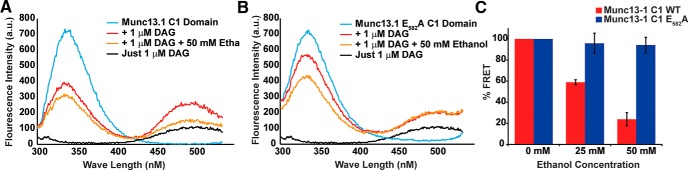
Ethanol binding to the C1 domain inhibits DAG binding. A, Spectral emission after excitation at 290 nm reveals FRET between the Munc13-1 C1 domain and dansyl-DAG (red trace). The C1 domain emission peaks at ∼335 nm (cyan trace), while the dansyl-DAG emission peak is found at 500 nm (black trace). This FRET is disrupted by 50 mM ethanol (green trace). B, Spectral emission of the Munc13-1 E582A mutation after excitation by 290-nm light is shown. C, The binding of dansyl-DAG as revealed by FRET emission at 500 nm is reduced at both 25 and 50 mM ethanol concentrations. The E582A C1 domain mutation fails to bind ethanol (Das et al., 2013). Ethanol does not inhibit dansyl-DAG binding to the E582A Munc13-1 C1 domain (n = 3 each; *p < 0.05, ***p < 0.001). Error bars are standard error of the mean (SEM).